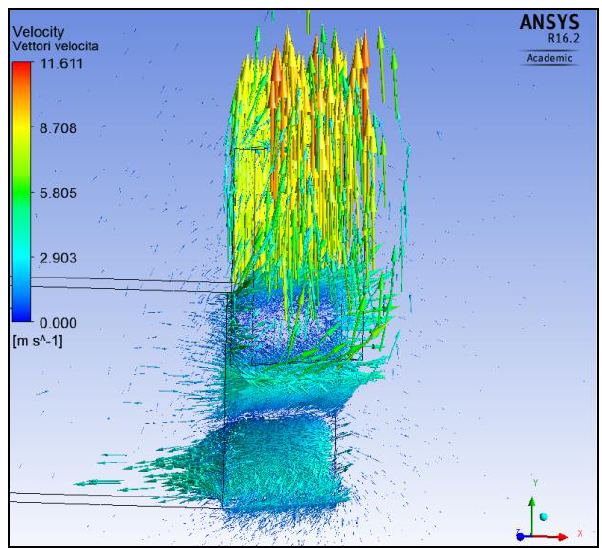
Figure 8. The velocity vectors’ directions in the air domain that move vertically upwards between the door and the furnace, and immediately outside the door.